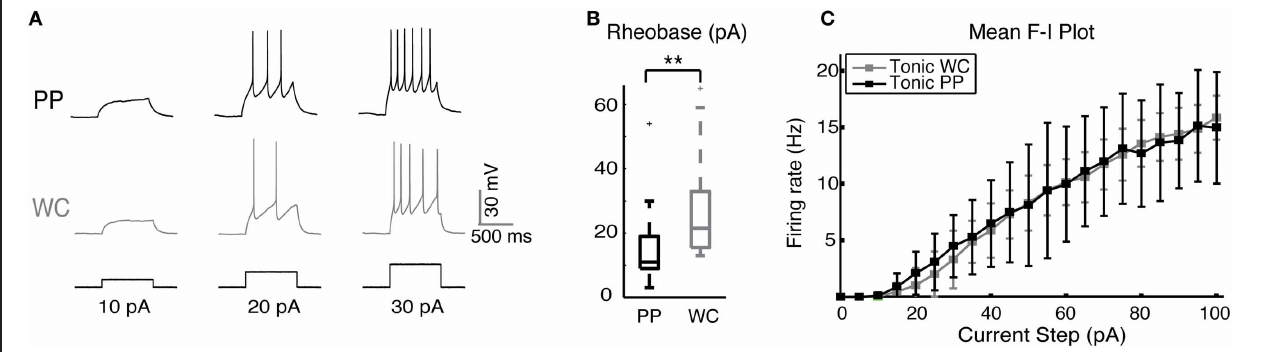
FIGURE 2 | Excitability of V2a INs in PPR and WCR. (A) Sample traces from a PP and a WC neuron held at − 60mV, showing responses to injected current steps of 10, 20, and 30pA. (B) The mean rheobase for all PP cells was significantly lower than that of all WC cells. (C) F-I plot of the mean